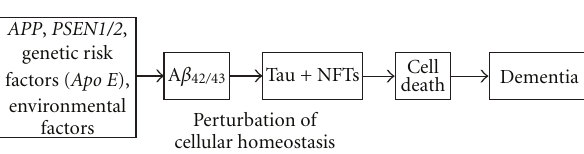
Figure 2: The original Amyloid Cascade Hypothesis (ACH) [7]. A β : β -amyloid, APOE: apolipoprotein E, APP: amyloid precursor protein, PSEN1/2 : presenilin genes 1 and 2 , NFTs: neurofibrillary